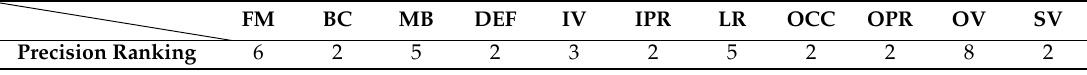
Table 2. HKSiamFC’s precision ranking in each scenario of all 15 trackers.